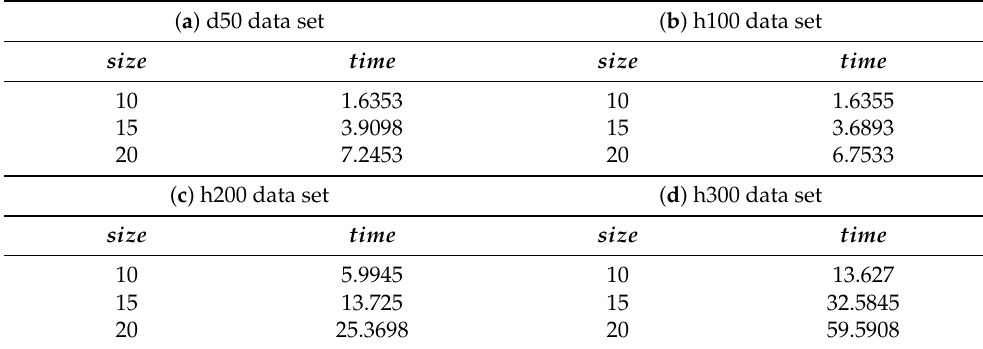
Table 4. Average pre-processing time in seconds depending on the size of the data set in the case of fixed gap penalty.